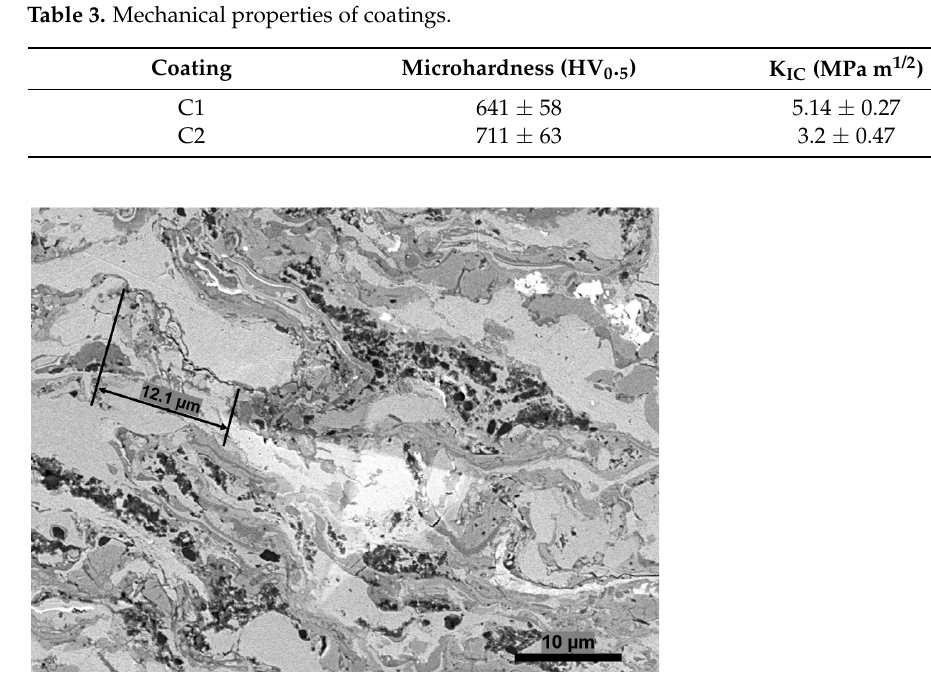
Figure 7. Indentation mark for K IC measurement in the C2 coating.